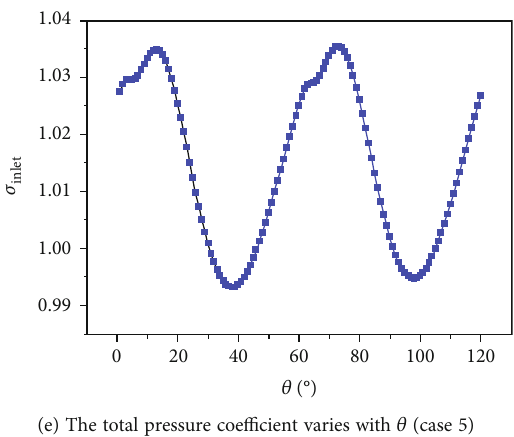
Figure 4: The total pressure coe ffi cient at the inlet of the